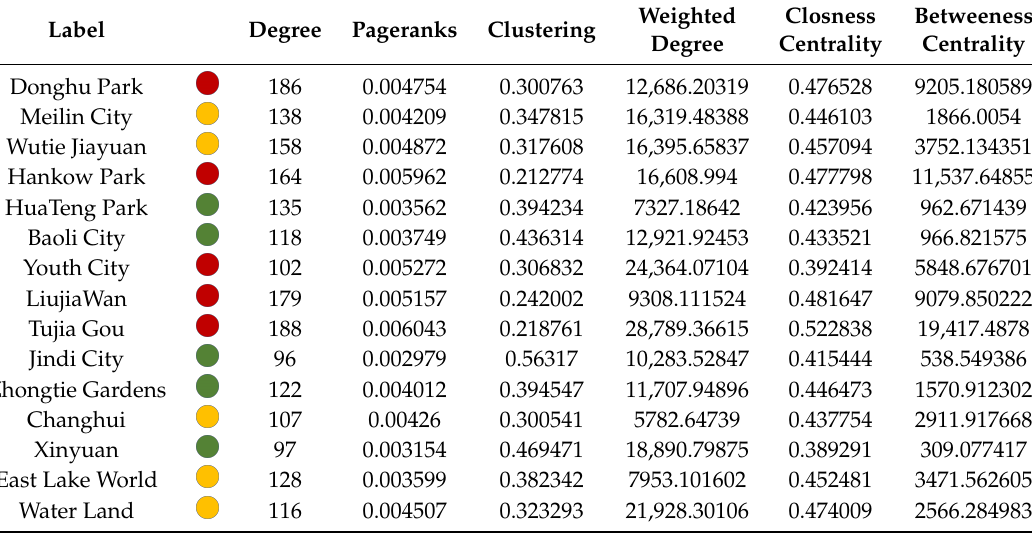
Table 1. Community node characteristics of the first 15 out-degrees.